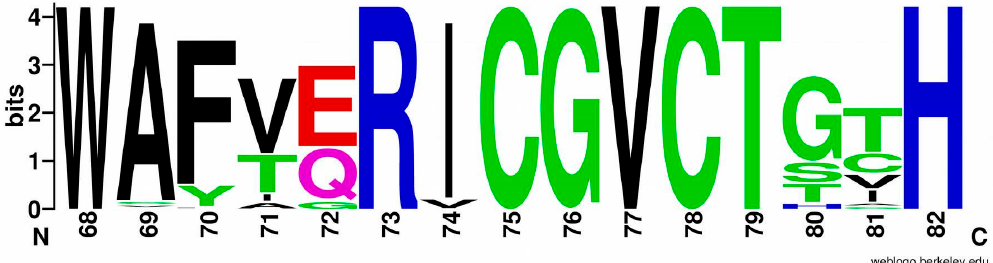
Figure 4. Sequence logo of large subunit consensus for hydrogenases from HydDB database (214 of 215 sequences, residues from 68 to 82). Hydrophobic residues are shown in black, amides are shown in magenta, other hydrophilic neutral residues are shown in green, negatively charged residues are shown in red, and positively charged residues are shown in blue. Ordinate shows information content of the alignment positions in bits (log 2 20 = 4.321928 if the residue is absolutely conserved).